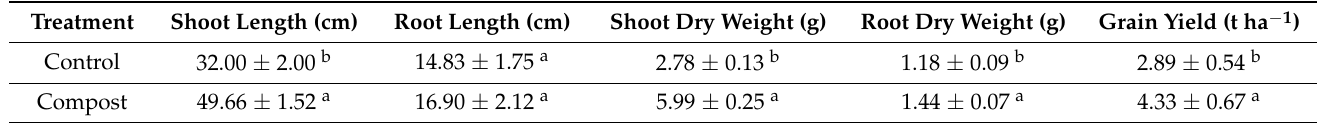
Table 1. Effect of date palm waste compost on growth and yield of barley plants. Different letters denote significant differences (Tukey’s HSD, p < 0.05).